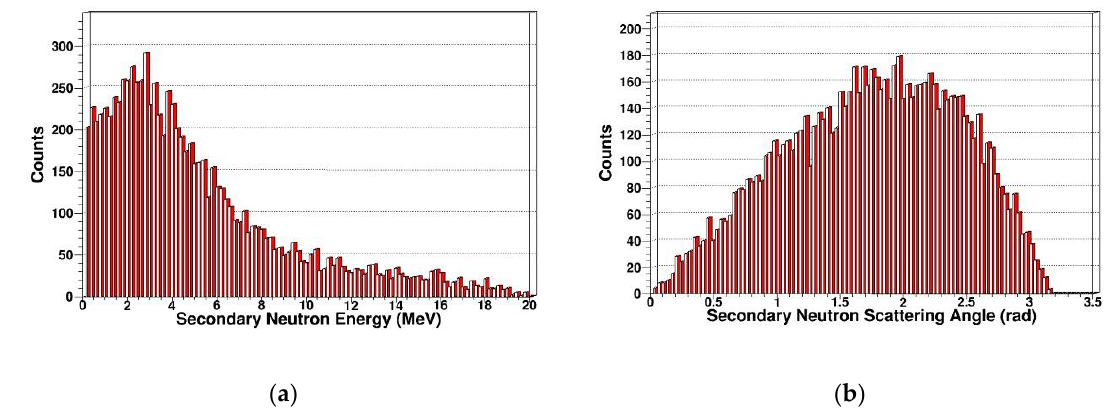
Figure 10. Secondary neutrons in SDD generated by neutrons: ( a ) Energy spectrum of secondary neutrons; ( b ) scattering angle distribution of secondary neutrons.